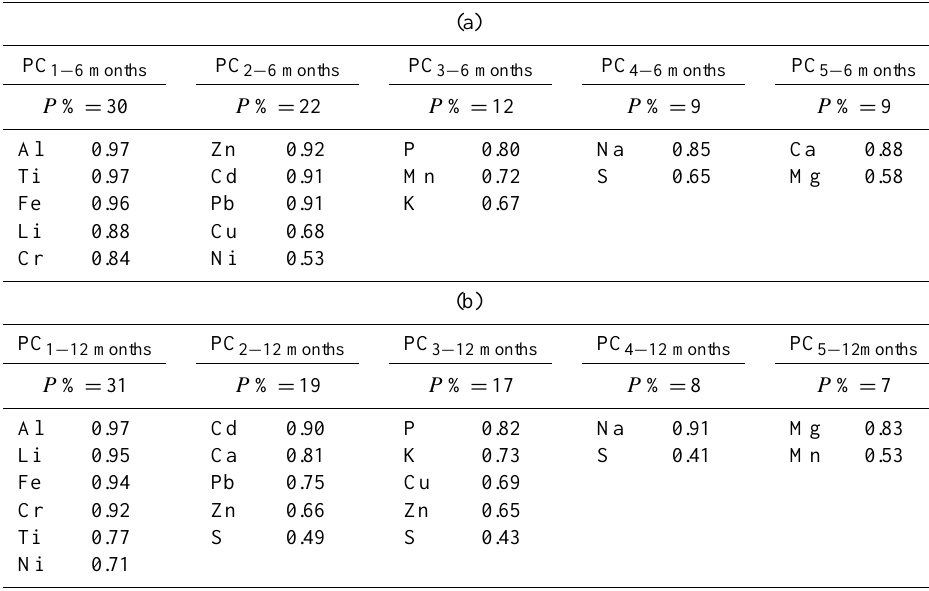
Table 4. PCA results after the normalized varimax rotation for trace element concentrations measured in lichen samples after (a) 6-month and (b) 12-month exposures. Loadings and percentage of explained variance ( P %) are